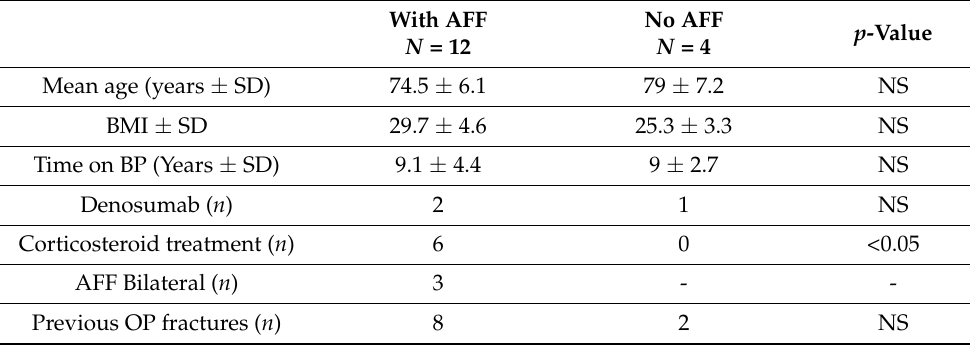
Table 1. Patient characteristics.